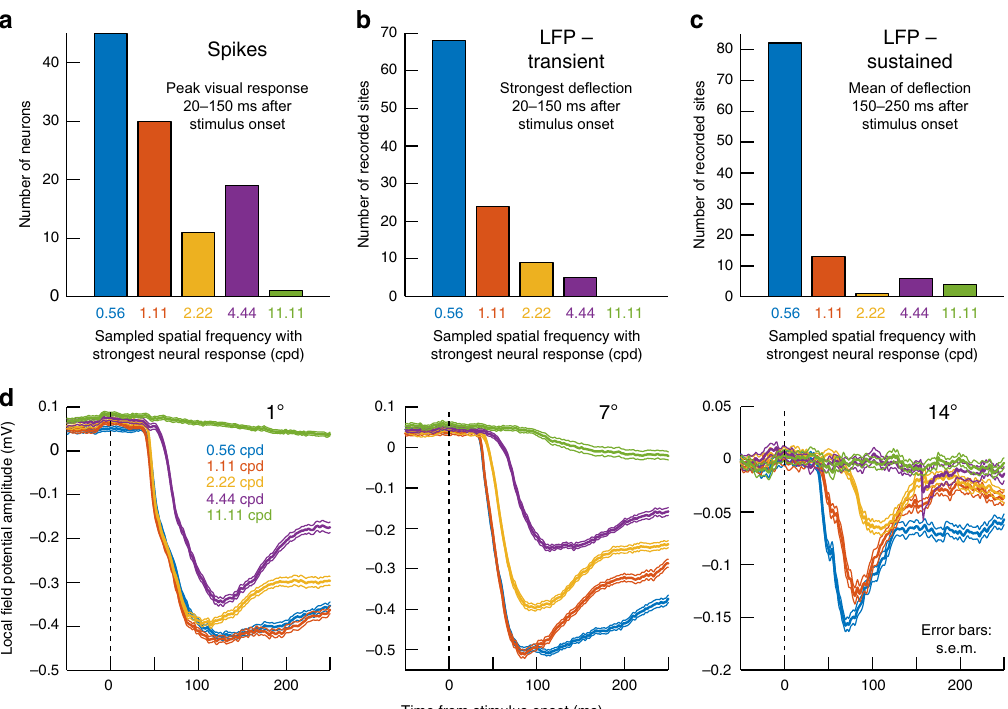
Fig. 7 Low-pass primate SC spatial frequency fi ltering characteristics. a Distribution of preferred spatial frequencies in our population. In this analysis, we binned neurons according to the presented spatial frequency (out of fi ve values) eliciting maximal response. More neurons were driven the strongest by the lowest spatial frequency (0.56 cpd). b We performed a similar analysis but on the transient evoked local fi eld potential (LFP) response (Methods; also see d for example evoked LFP responses, which are negative going). The number of electrode penetrations showing maximal response for 0.56 cpd was even higher than for the isolated neurons in a . c This effect was even stronger in the sustained LFP response starting after 150 ms from stimulus onset. Thus, at the population level re fl ected by LFP signals, the primate SC is primarily tuned to low spatial frequencies. d Stimulus-evoked LFP responses from the same electrode penetrations in which the example neurons of Fig. 6a were isolated and recorded. In the LFP, all three electrode tracks, regardless of eccentricity, showed a preference for low spatial frequencies (stronger negative de fl ections), even in the near-foveal SC region where the neuron preferring 3.5 cpd in Fig. 6a was isolated. This means that the SC over-represents low spatial frequencies in neural sensitivity. Error bars denote Brie fl y, we placed a recording chamber centered on the midline, and we angled it to point towards a stereotaxically de fi ned point 1 mm posterior of and 15 mm above the inter-aural line. The chamber angle was posterior of vertical (by 38 and 35deg for monkeys P and N, respectively). Monkey recording task . The monkeys sat in a primate chair placed in a dim room in front of a cathode ray tube (CRT) monitor having a refresh rate of 120 Hz. The monitor ’ s luminance pro fi le was linearized using Gamma-correction, and we used eight-bit resolution for control of individual luminances (i.e. 256 levels of gray). The display was con fi gured for a resolution of >22 pixels per deg, and the lumi- nance of the standard gray background over which stimuli were presented was 21cd m − 2 . Viewing distance was 45cm, and we used a custom-built real-time experimental control system communicating with a dedicated computer running